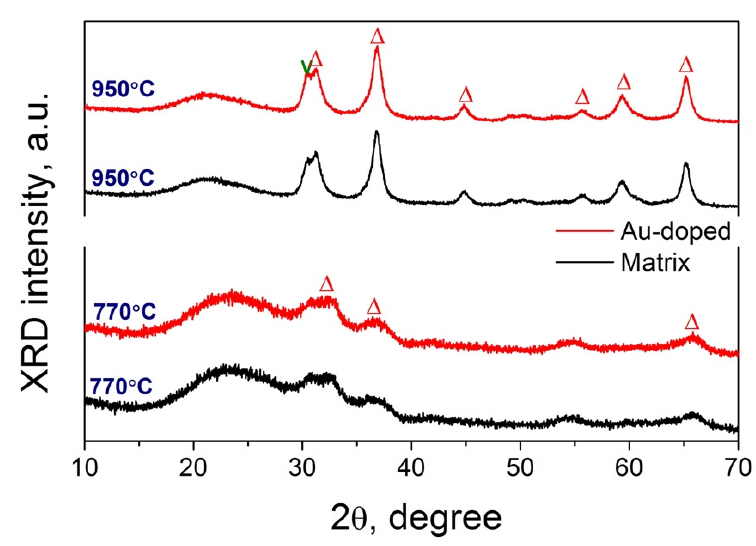
Figure 4. XRD patterns of the glass samples within the Matrix and Au-doped series after treatment at 770 or 950 °C for 20 h. Symbols are indicated the following crystal phases: Δ —#01-074-1136 (ZnAlO 4 ), V—#01-074-9434 (ZrTiO 4 ).